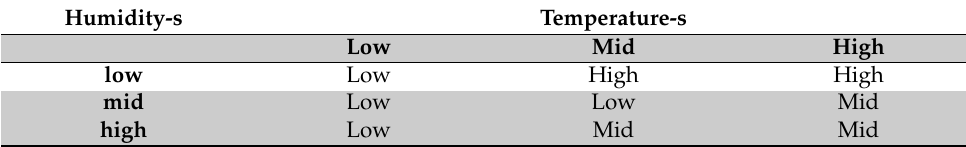
Table 7. Rules for SMDD (Long Time).